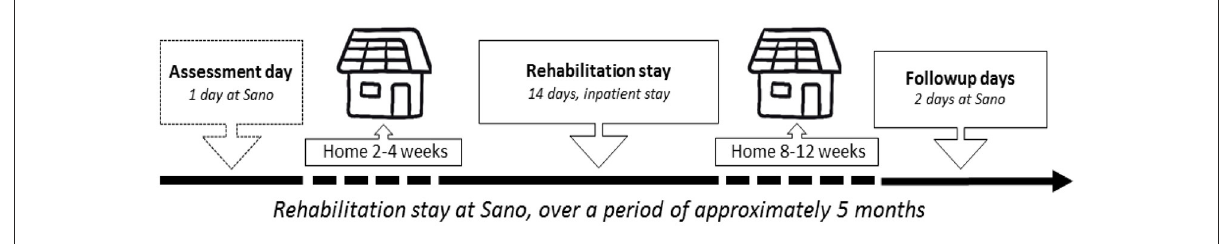
FIGURE1 A rehabilitation process including periods at the rehabilitation center and at home.